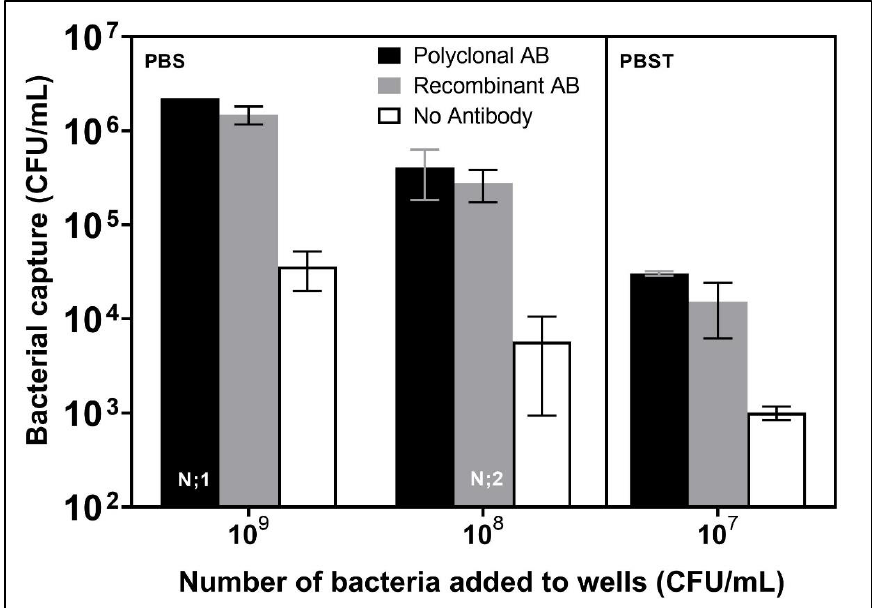
Figure 2. Number of bacteria captured per well with pAb (Black), recAb (grey) or without Ab (white) for different concentrations of L. pneumophila added to wells ( n = 3, except where indicated differently on the bottom of the bar). The results were quantified by qPCR (MIP primers). Error bars are shown to indicate standard deviation. When suspensions at 10 9 CFU/mL were added to wells coated with Ab, 2.2 × 10 6 CFU/mL (0.22% of the input bacteria) were captured with pAb and 1.5 × 10 6 CFU/mL (0.15%) with recAb, whereas without Ab, a non-specific capture of 3.6 × 10 4 CFU/mL (0.0035%) was observed. Exposure to suspensions at lower concentrations resulted in spe- cific capture of 4.1 × 10 5 ± 2.2 × 10 5 (0.41%) CFU/mL by pAb and 2.8 × 10 5 ± 1.1 × 10 5 (0.28%)